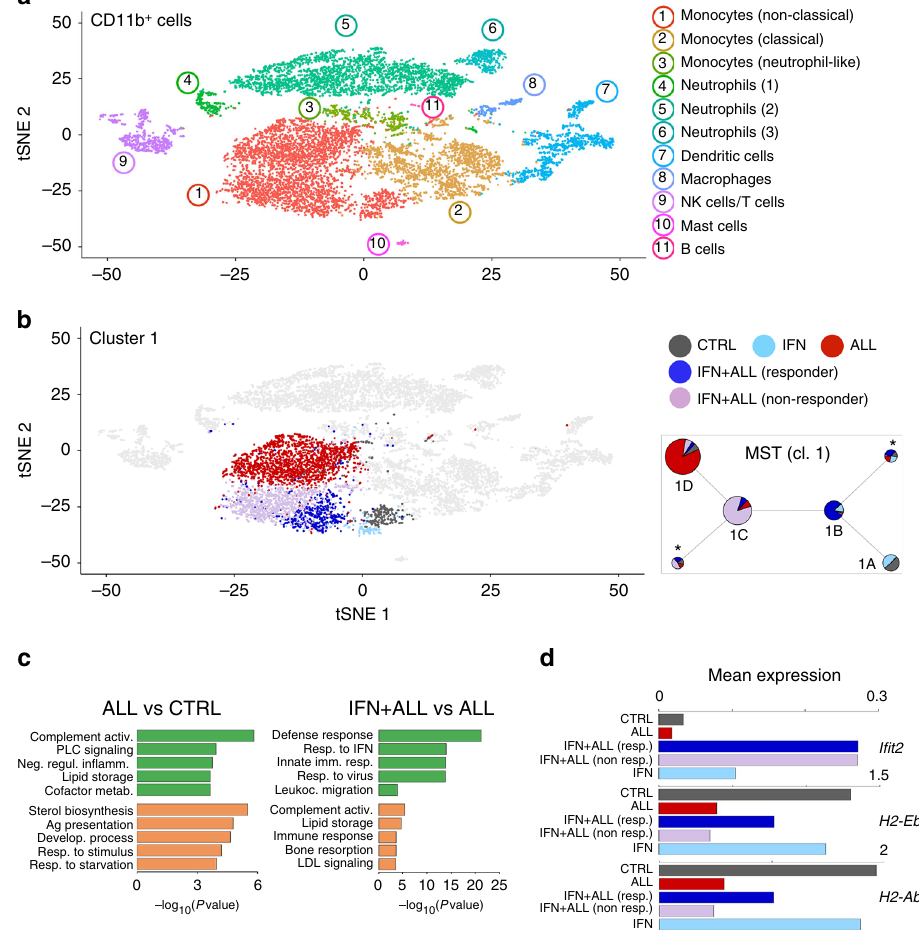
Fig. 5 Single cell transcriptional reprogramming of tumor-associated myeloid cells by IFN gene therapy. a tSNE plots incorporating scRNA-Seq data from 10,821 CD11b + cells sorted from the spleen of CTRL or ALL mice, treated or not with IFN gene therapy. Transcriptionally de fi ned clusters and associated cell types are indicated by numbers and colors in the legend. b Right plot: tSNE plots incorporating single-cell RNA-Seq data of cells from cluster 1 (non- classical monocytes), colored based on the experimental condition. Left plot: Minimum spanning tree (MST) analysis of scRNA-Seq data from cluster 1 (non-classical monocytes), after sub-clustering. Each pie represents a sub-cluster and shows its size (number of cells) and composition (experimental condition). Pies marked by asterisks represent minor sub-clusters with dispersed composition. c GO terms enriched in the top 100 genes (ranked by log 2 FC) up-regulated (green) or down-regulated (orange) in scRNA-Seq data from cluster 1 (non-classical monocytes) in the indicated comparisons. d Mean expression (log transformed TPM values, normalized for number of cells) in non-classical monocytes of selected genes for the indicated (Fig. 7f). We adjusted the time of infusion between the two groups to infuse OT-I cells at comparable leukemia burden (Fig. 7g and Supplementary Fig. 12a) and analyzed mice 3 days after. We observed substantially higher numbers of OT-I cells in the spleen and BM of leukemia-injected IFN than control mice (Fig. 7h, spleen and BM: * p < 0.05 and ** p < 0.01 respectively, Mann-Whitney). In both groups of mice, OT-I cells up-regulated the activating receptor LAG3, and acquired central or effector memory phenotype, whereas OT-I cells maintained the naive phenotype of the harvest in tumor-free control mice (Supple- mentary Fig. 12b, c). Leukemia burden was signi fi cantly reduced in IFN vs. control mice already at early times after adoptive T cell transfer (Supplementary Fig. 12d. BM and spleen: ** p < 0.01 and *** p < 0.001 respectively, Mann – Whitney). Whereas nearly all leukemic cells of control mice expressed the NGFR marker, there was an increasing fraction of NGFR-negative cells in IFN mice, indicating selective pressure against OVA-ALL (Supplementary Fig. 12e). We then explored the synergy of IFN gene therapy and OT-I T cells in promoting survival (Fig. 7i, right panel). Whereas adoptive transfer of OT-I T cells resulted in 20% mice survival vs